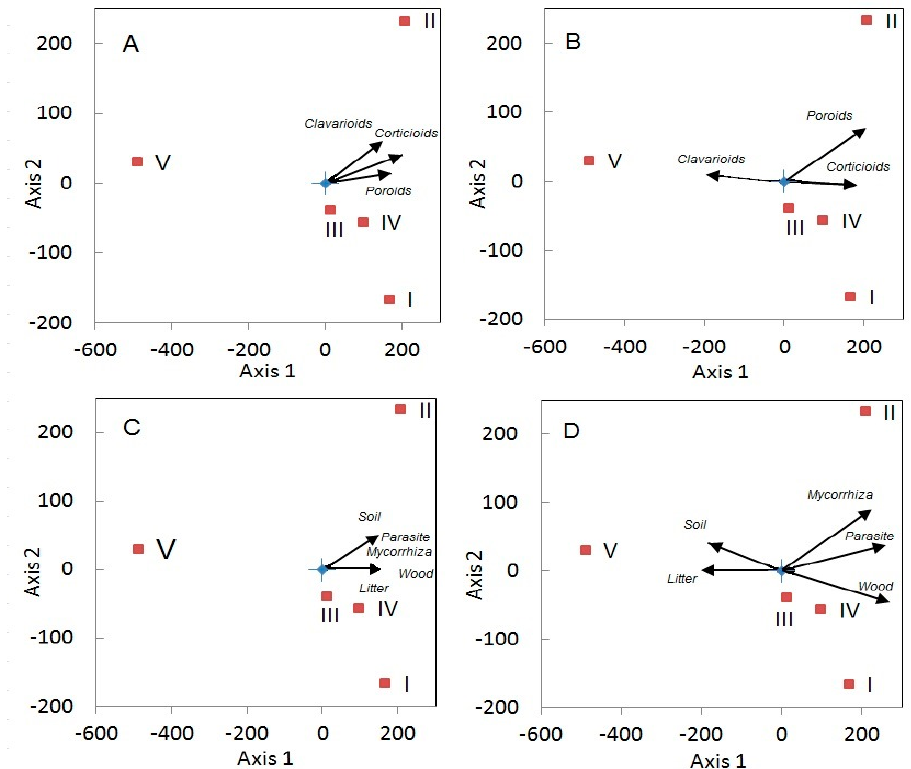
Figure 5. Relationship between aphyllophoroid fungal species richness at different altitudinal levels (I–V) and the structure of the mycobiota. ( A ) Species richness of fungal morphological groups (corticoid, poroid, clavarioid); ( B ) Proportion of fungal morphological groups; ( C ) Species richness of fungal ecological groups (wood, litter or soil saprobes, parasites, mycorrhizal); ( D ) Proportion of fungal ecological groups.